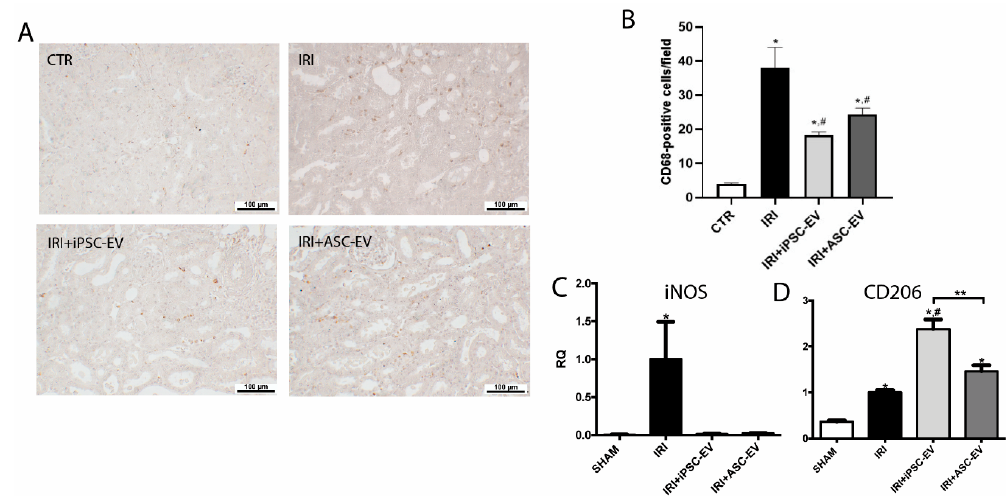
Figure 5. iPSC-EV promoted the reduction of the inflammatory response induced by IRI. ( A ) Representative photomicrographs of the renal tissue stained for ED-1 by immunohistochemistry. From the left image to the right: SHAM, IRI, IRI+iPSC-EV, and IRI+ASC-EV (scale bars = 100 μ m). ( B ) Quantification of the number of CD68-positive cells/field. SHAM, n = 10 fields for 4 kidneys; IRI, n = 10 fields for 5 kidneys; IRI+iPSC-EV, n = 10 fields for 8 kidneys; IRI+ASC-EV, n = 10 fields for 4 kidneys. ( C ) mRNA levels of iNOS and ( D ) CD206 in renal tissue expressed as relative quantification (RQ) with respect to the IRI group (SHAM, n = 3; IRI, n = 3; IRI+iPSC-EV, n = 5; IRI+ASC-EV, n = 3). Data represent mean ± SEM (* indicates statistical difference to SHAM group; # indicates statistical difference to IRI group; ** indicates statistical difference to IRI+iPSC-EV group; p <0.05 assessed by one-way ANOVA followed by Tukey’s test).